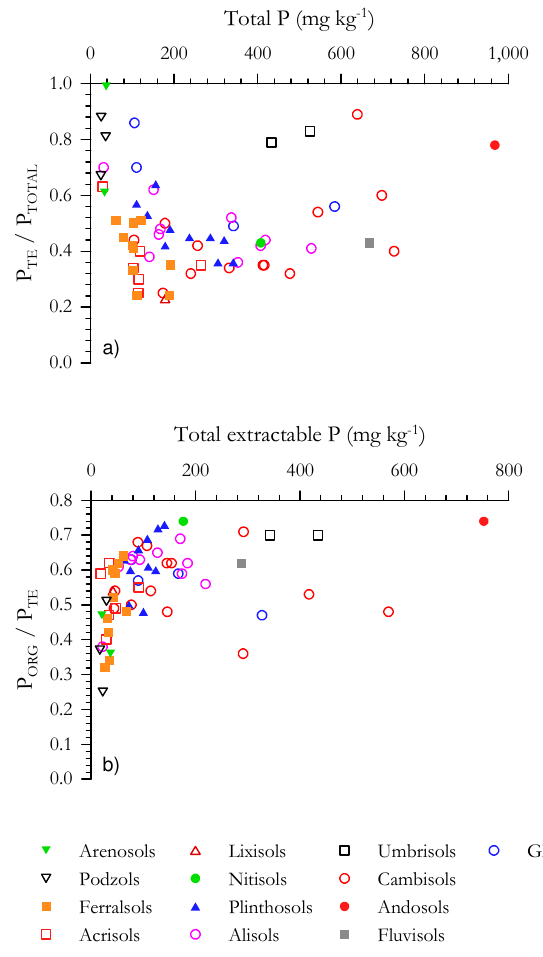
Fig. 9. (a) and (b) : Variations in the proportion of total phosphorus pool which is assumed to be labile (total – residual, top chart), and the fraction of such labile pool which is formed by organic phos- phorus